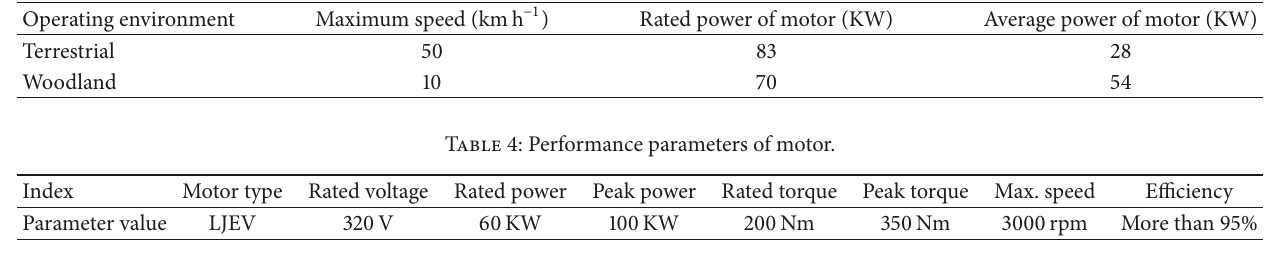
Table 3: Total motor power of CFJ20H hybrid power harvester.